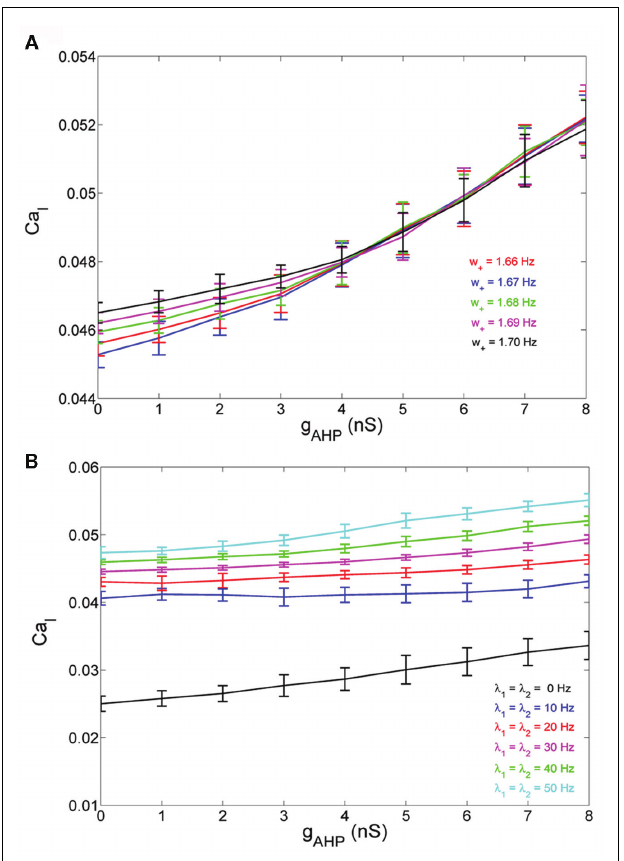
FIGURE 4 | (A) Average gating variable Ca I emulating the Ca 2 + concentration of the inhibitory population as a function of the level of adaptation at different recurrent connectivities for external stimulus λ = λ = 40Hz. (B) The average gating variable Ca 1 2 of neuronal adaptation at different external stimuli for recurrent connectivity w + =